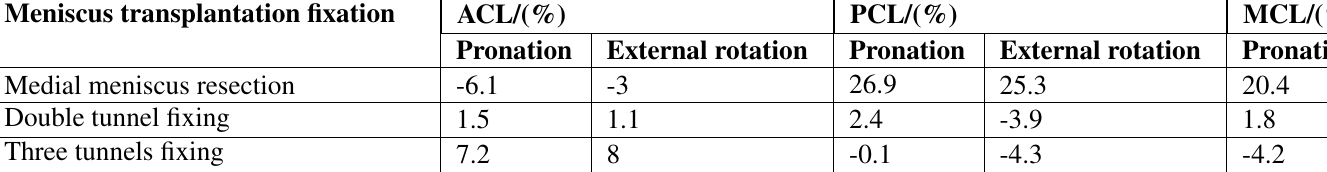
ACL, anterior cruciate ligament. Fig. 6 Maximum equivalent stress of the